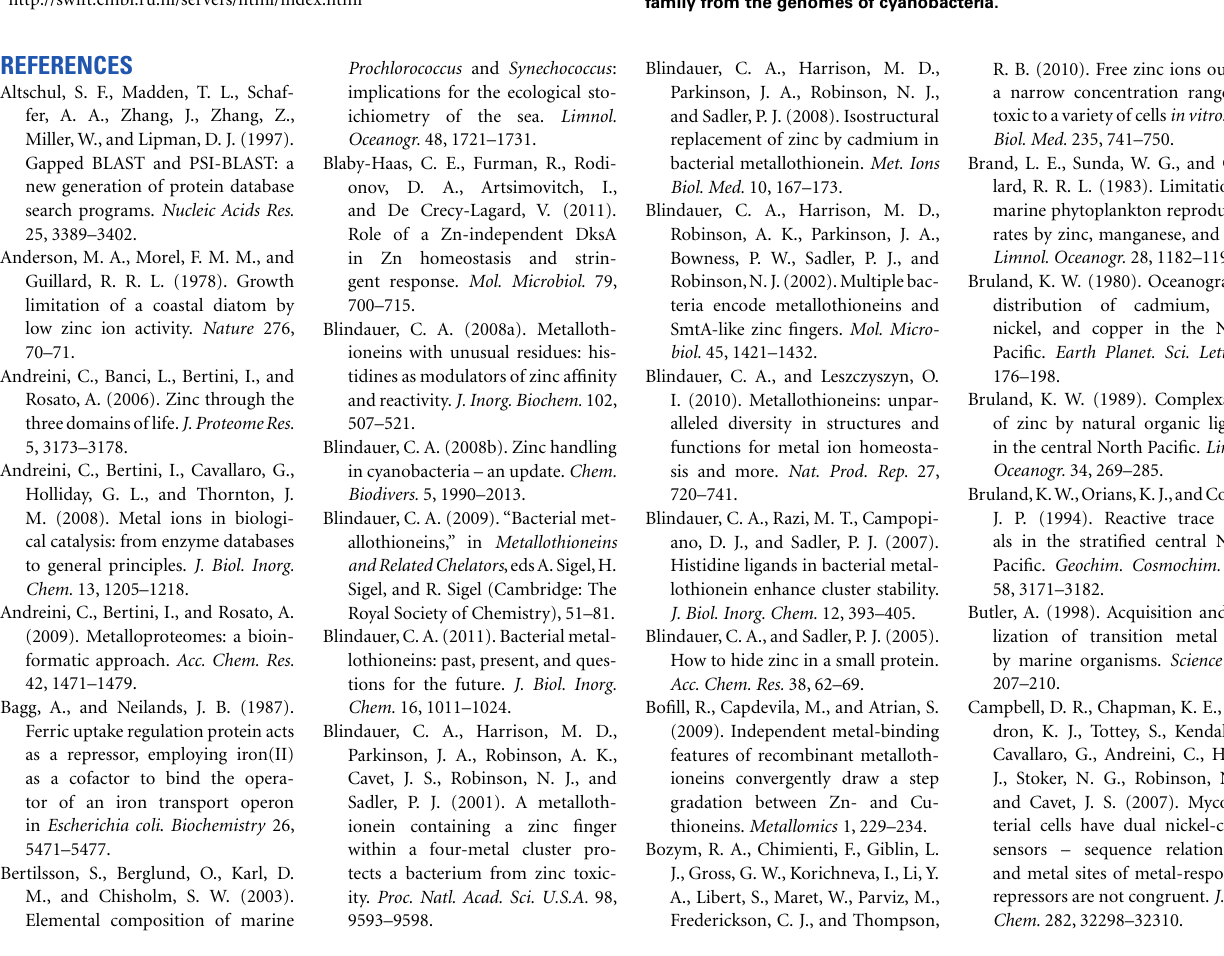
Figure S1 | Phylogenetic tree for Fur/Zur-like proteins extracted from genomes of marine cyanobacteria. Figure S2 | Sequence alignment of Fur/Zur-like proteins. Figure S3 | Phylogenetic tree for COG0523 family members. Figure S4 | Sequence alignment of members of the COG0523 protein family from the genomes of